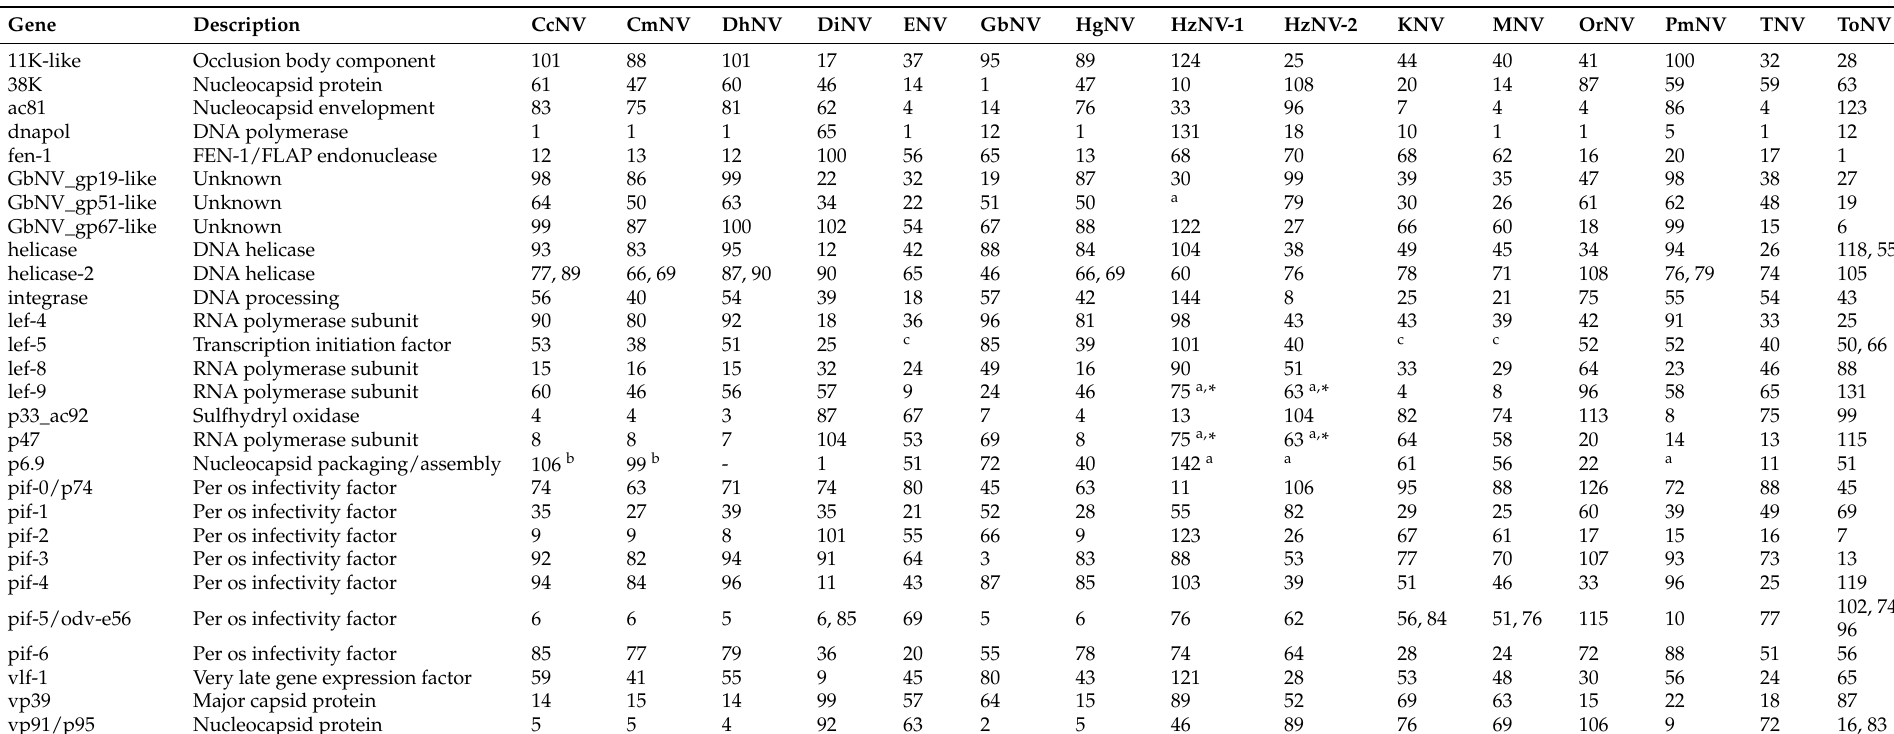
Table 3. List of identified core genes across 15 nudiviruses. Numbers represent open reading frame (ORF) numbers for each of the nudiviruses. Genes (proteins) that were not reported in the proteomes on NCBI, but that were subsequently found in the current or previous studies are indicated and referred to in the footnote.